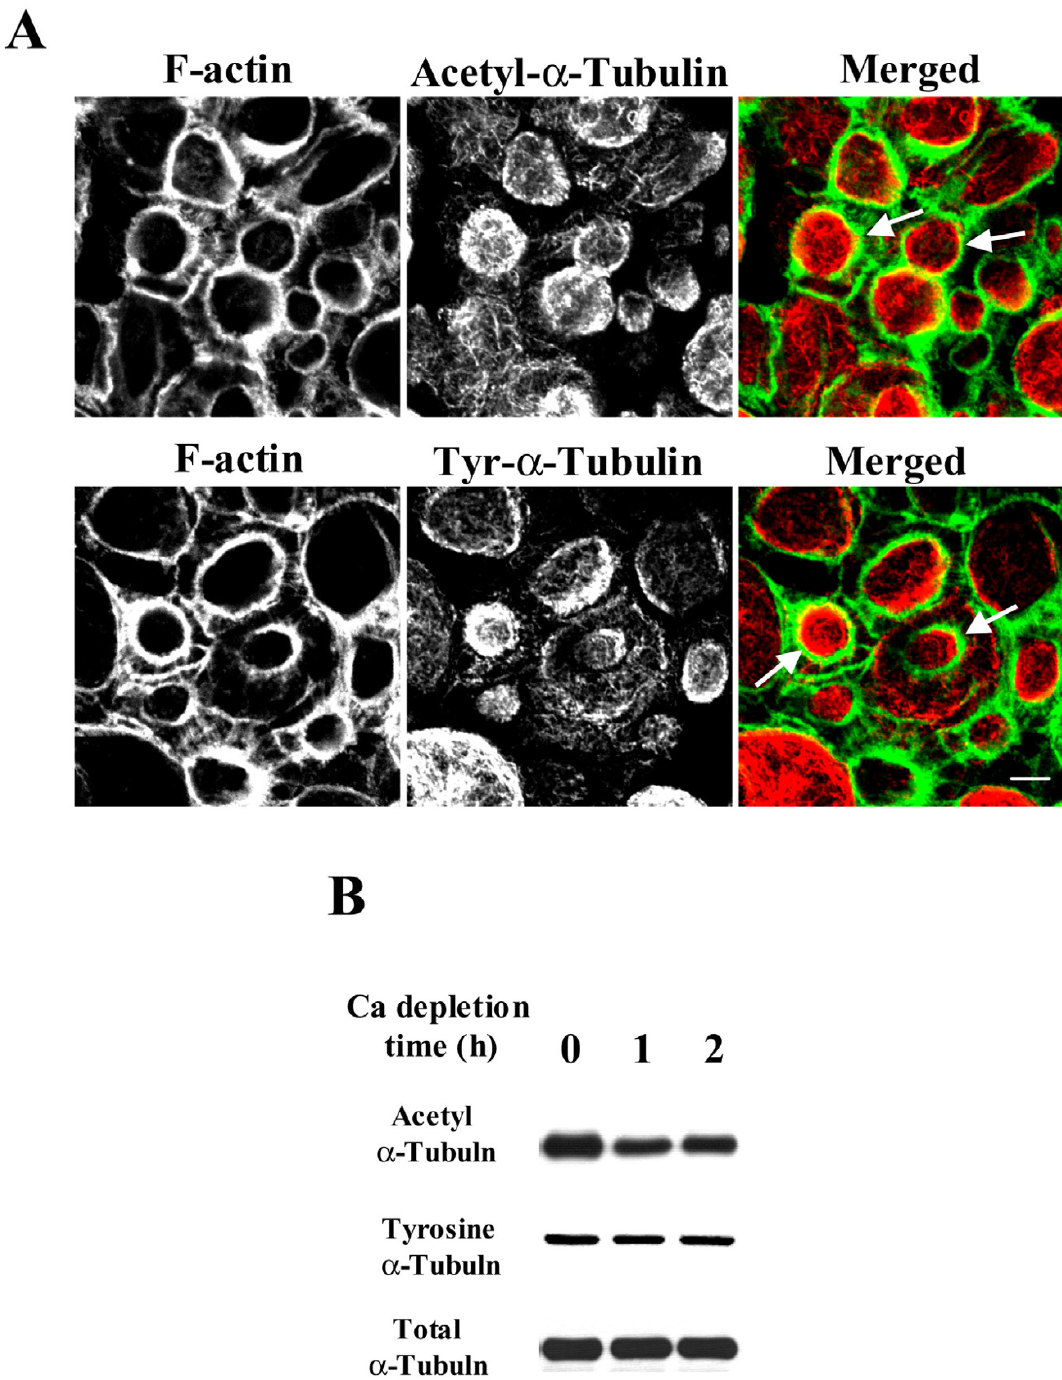
Figure 5 Calcium depletion causes reorganization of acetylated and tyrosinated apical microtubules and decreases the amount of acetylated microtubules. (A) Acetylated (Acetyl) and tyrosinated (Tyr) microtubules (red color) are accumu- lated inside of contractile F-actin rings (green color) after 1 h of calcium depletion of SK-CO-15 cells. Bar, 5 µ m. (B) Repre- sentative Western blots demonstrate significant change in expression of acetylated but not total or tyrosinated α -tubulin in SK-CO-15 cells after 1 and 2 h of calcium depletion relatively to a non-depleted